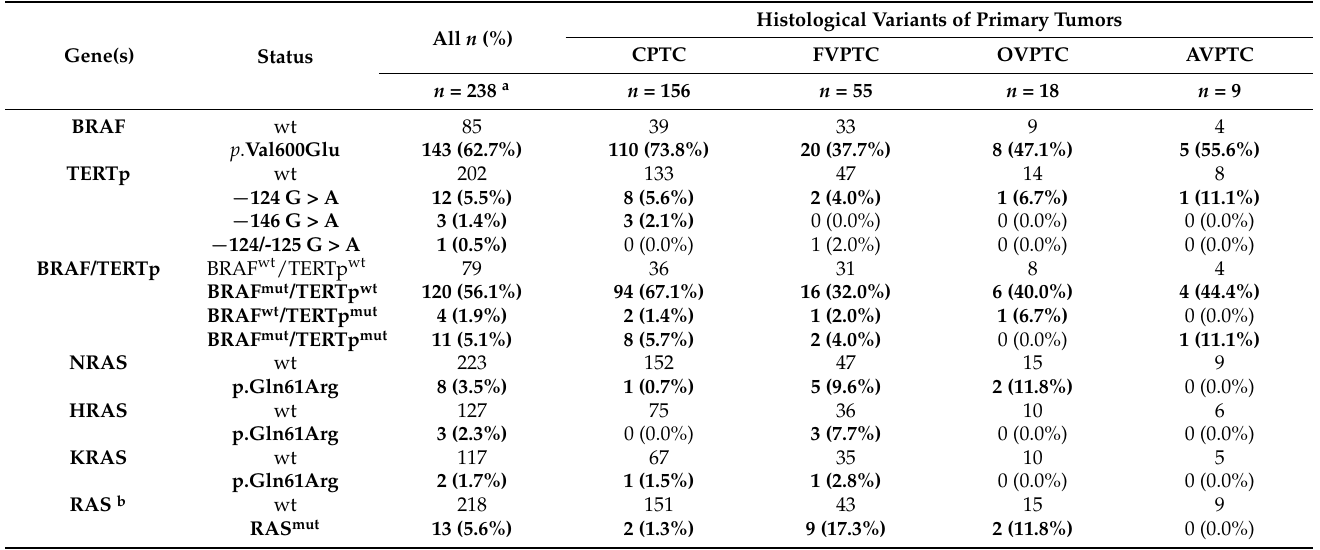
Table 2. BRAF, TERTp, and RAS molecular status in primary tumors and distribution in the different PTC